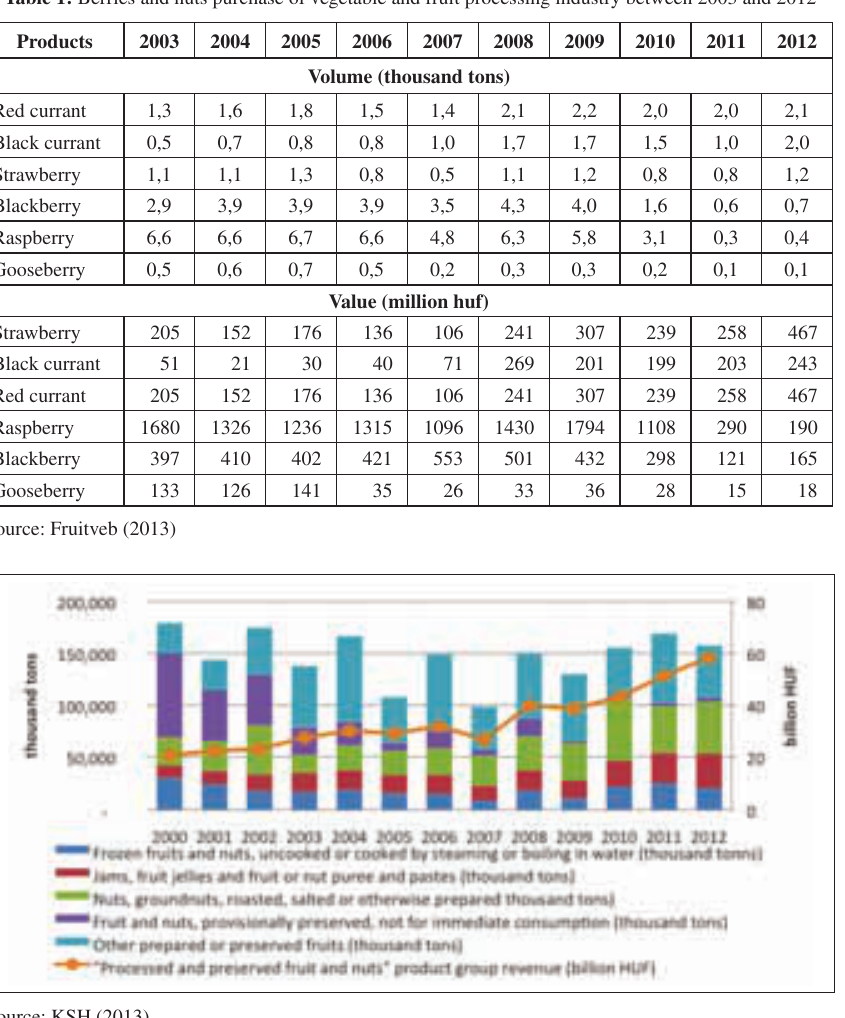
Figure 2: Production structure and quantity of ‘processed and preserved fruit and nuts’ product group (2000-2012)